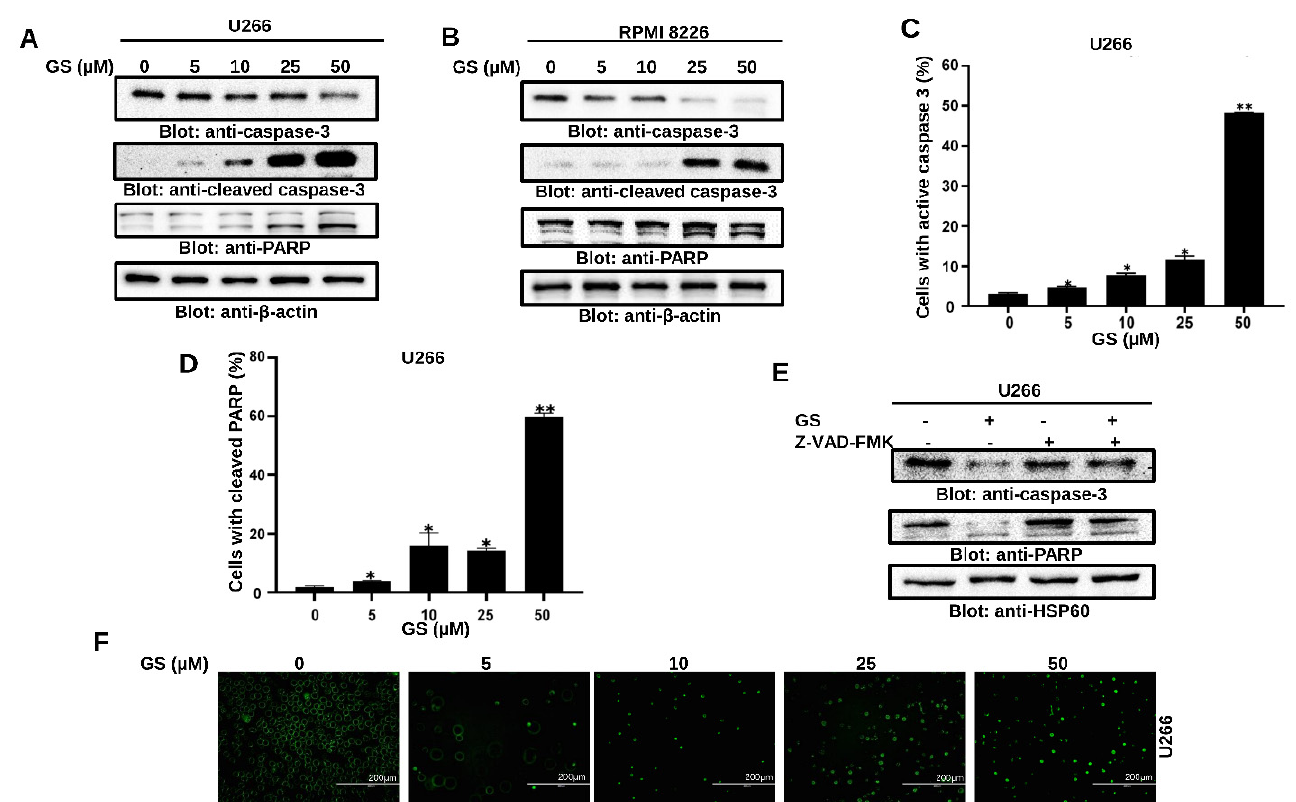
Figure 4. GS-mediated PARP cleavage and caspase activation in MM cells. U266 ( A ) and RPMI 8226 ( B ) cells were treated with 5, 10, 25, and 50 µ M of GS for 48 h. 50 µ g of proteins were resolved on SDS-PAGE and probed against caspase-3, cleaved caspase-3, PARP, and β -actin. Flow cytometric analysis of GS-mediated activation of caspase-3 ( C ) and cleavage of PARP ( D ) in U266 cells. The graph displays the mean ± SD of three different experiments (* p < 0.05, ** p < 0.01). U266 cells were treated with 30 µ M z-VAD-FMK for 2 h, followed by 50 µ M of GS for 48 h. Cells were lysed, and protein expressions of ( E ) caspase-3, PARP, and HSP60 were determined. ( F ) Representative bar, 200 µ m). Full Western blot images can be found at Supplementary Materials File